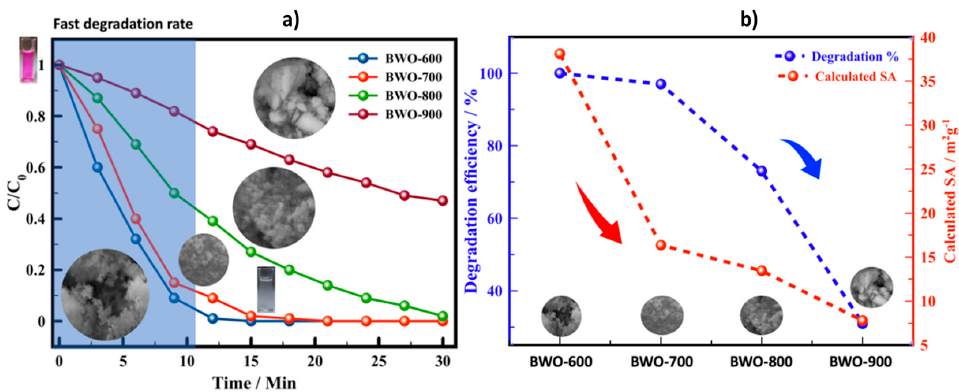
Figure 6. ( a ) Electrocatalytic activity of the prepared BWO samples at different temperatures and ( b ) evolution of degradation efficiency as a function of calculated surface area.